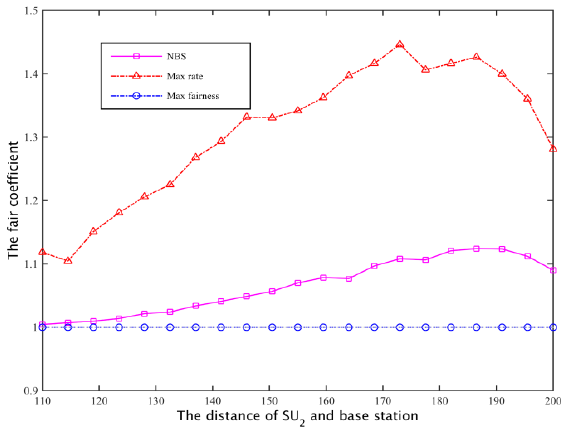
Figure 25. The comparison of fairness II.